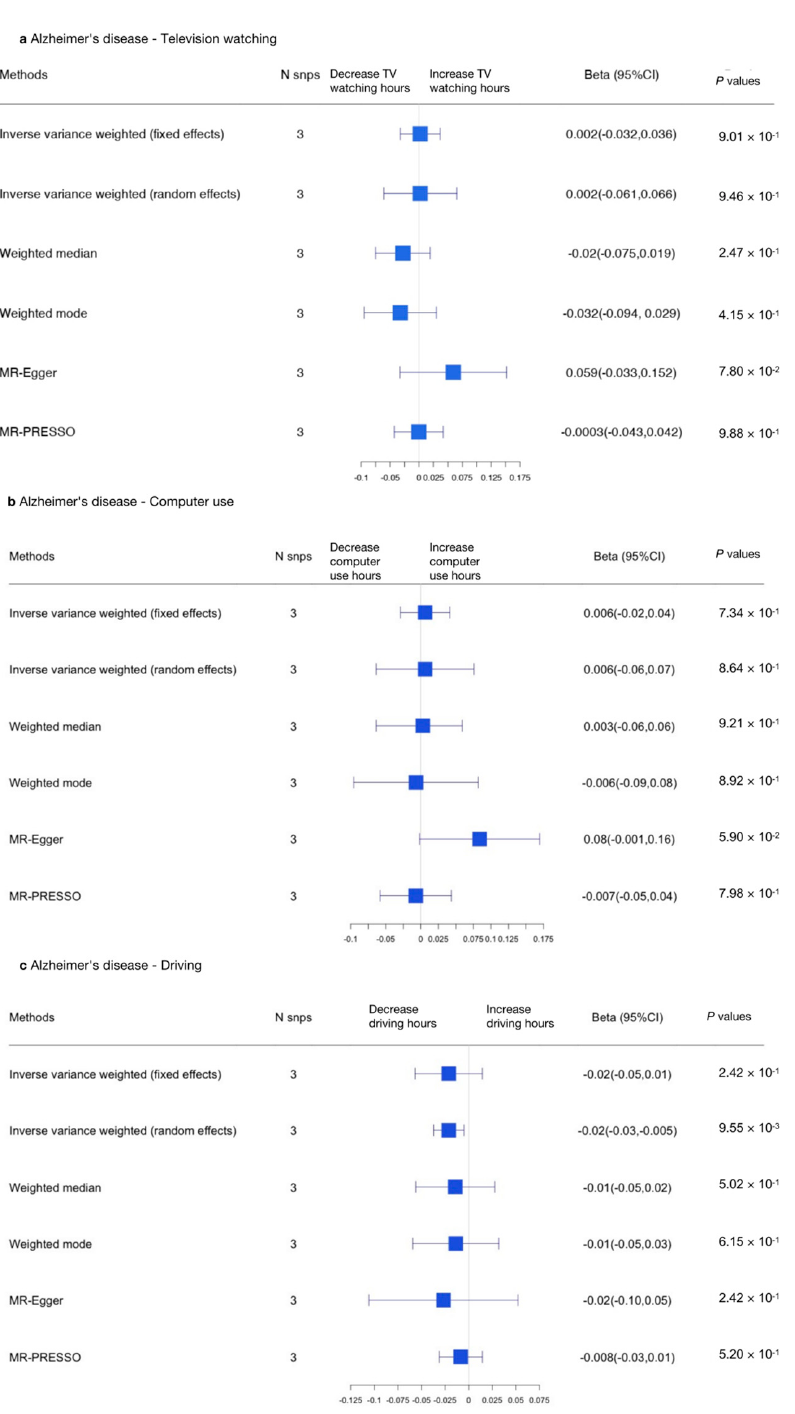
pleiotropic effect in any phenotype, MR-Egger, weighted median, MR pleiotropy residual sum and outlier (MR-PRESSO), outlier-corrected MR-PRESSO, and weighted mode methods. Odds ratios (ORs) as well as 95% confidence intervals (95% CIs) are presented on the x axis. A two-sided p -value of less than 0.05 was considered statistically significant.